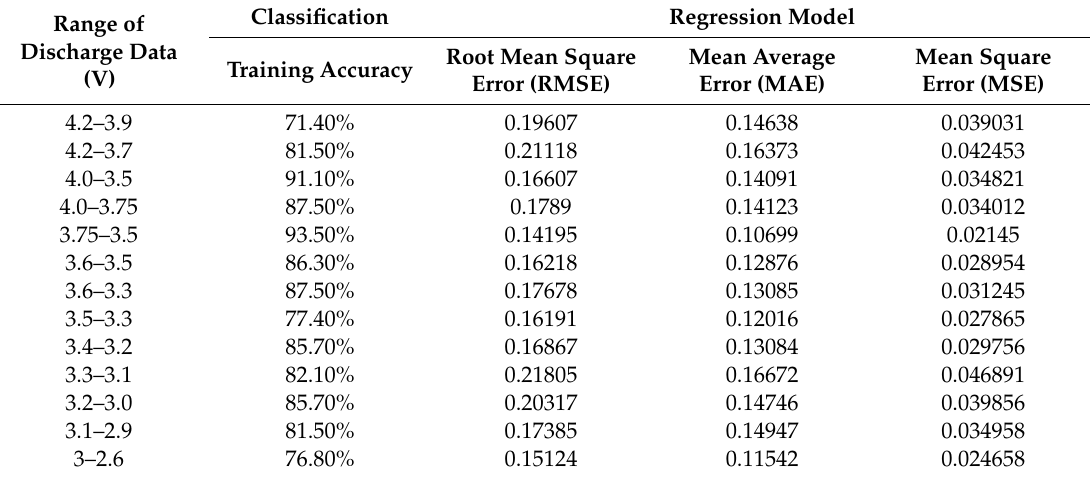
Table 3. Performance of classification and regression models under different PDD range.